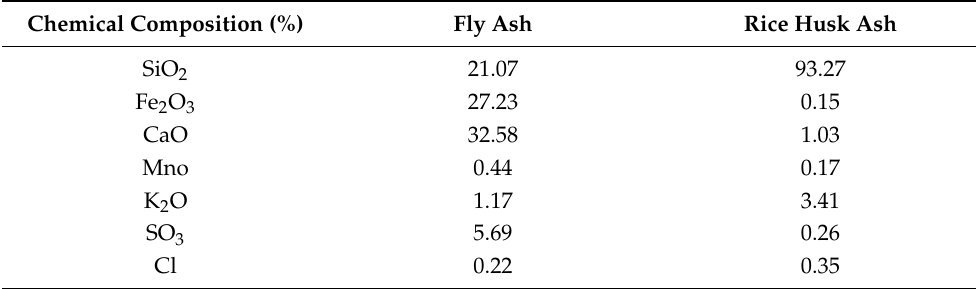
Table 1. Chemical composition of fly ash and rice husk ash (by weight). Chemical Composition